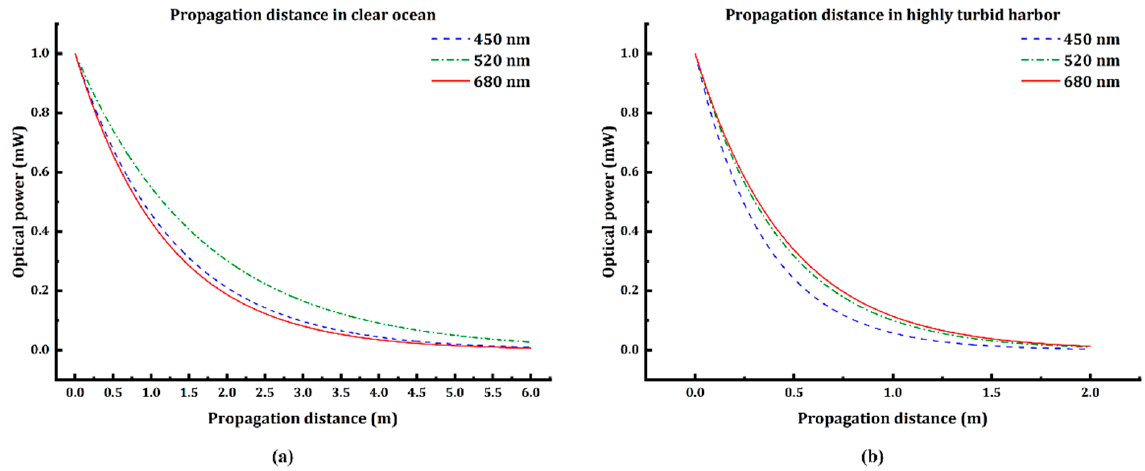
Figure 17. The propagation distance of different wavelengths in ( a ) clear ocean water, ( b ) a highly turbid harbor.